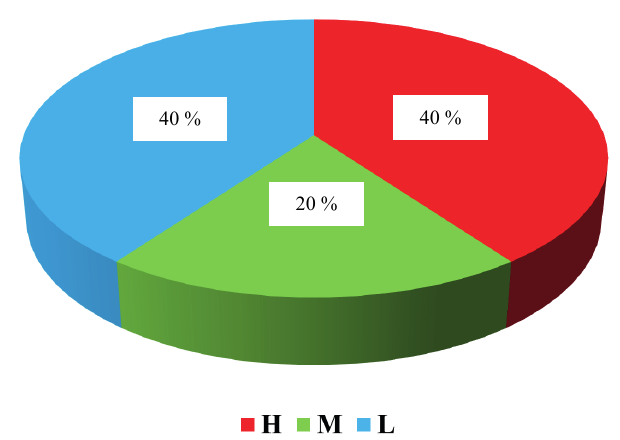
Fig. 4. Comparison of FMEA risk levels in the construction phase.